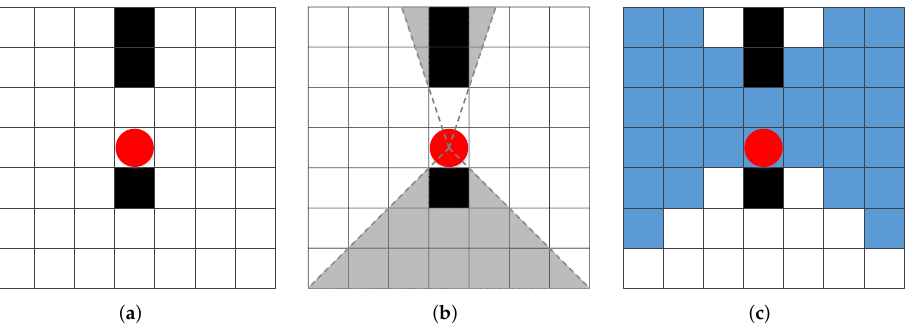
Figure 1. An example of Exploration Range. ( a ) shows the obstacles around the agent, where the red solid circle represents the agent, and the black squares represent two obstacles. ( b ) shows the range that can be covered by the “radar wave” emitted from the agent. The gray shaded areas indicate that these areas are not covered by the “radar wave”. ( c ) shows whether each cell in this scenario can be regarded as an explored area under Definition 3 when m = 3. The blue cells are the areas that the agent has been explored, while the agent has not explored the white